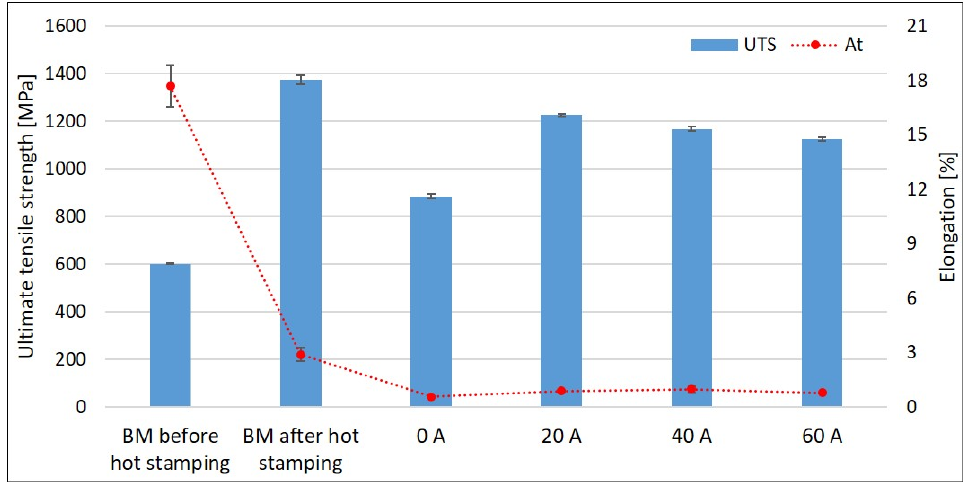
Figure 13. Tensile properties of the BM and welded